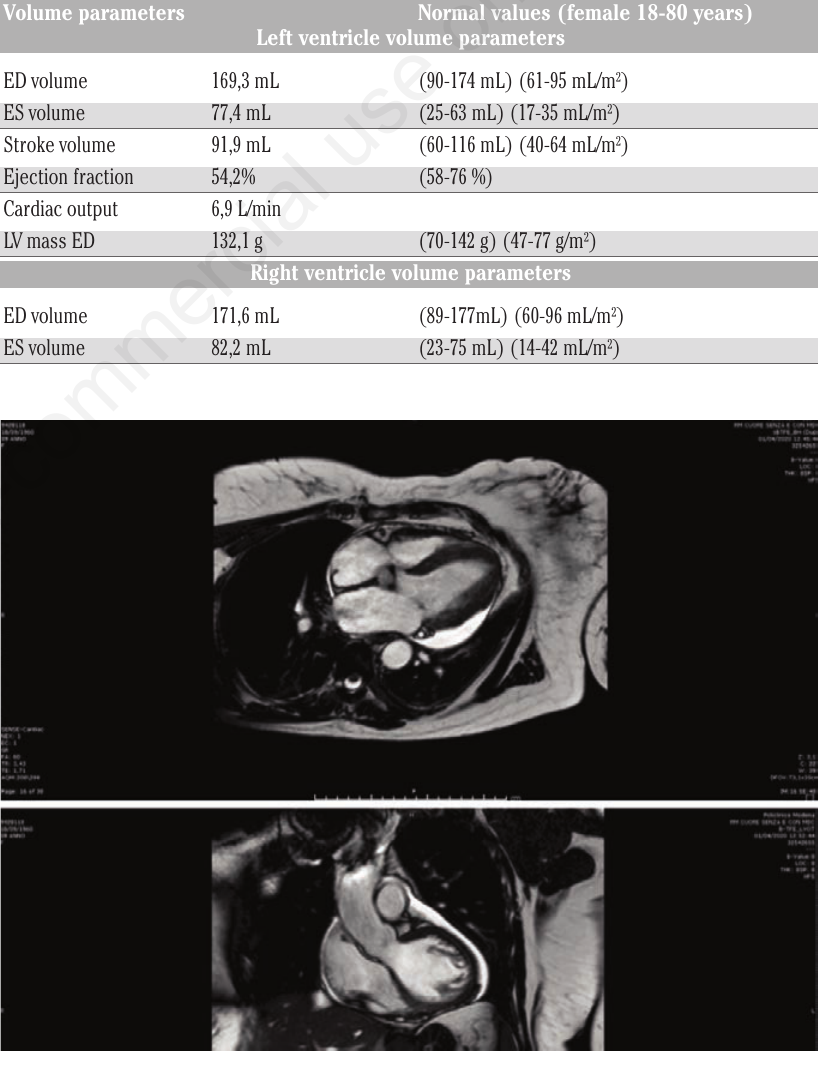
Figure 1. Cardiac MRI